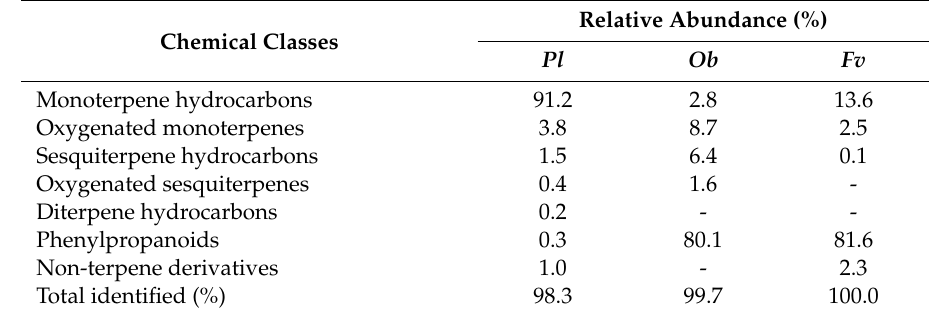
Relative Abundance